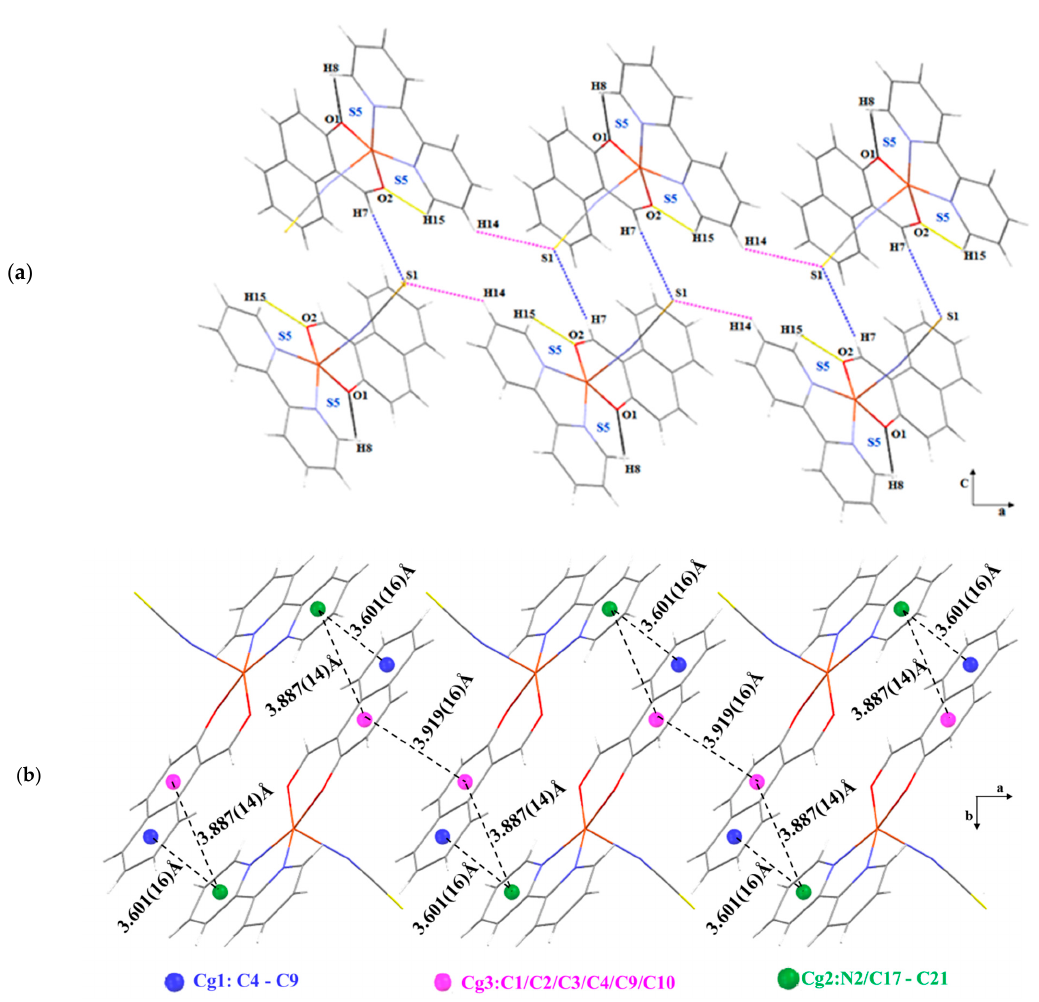
Figure 3. ( a ) Zig-zag chains of C-1 formed by hydrogen bonds (dashed lines), ( b ) the aromatic ring organization with centroid–centroid distances (Å). In addition, the C-1 complex exhibits three π ··· π stacking interactions; the first is be- tween the centroid of the 2-hydroxy-1-naphthaldehyde ring Cg1 (C4 to C9) and the cen- troid of the 2,2 ′ -bipyridine ring Cg2 (N2 and C17 to C21), with a Cg1…Cg2 distance of 3.601 Å, the second is between the Cg3 (C1/C2/C3/C4/C9/C10) rings of the 2-hydroxy-1- naphthaldehyde, with a Cg3···Cg3 distance of 3.919 Å, and the third is between Cg2 and Cg3, with a distance of 3.887 Å (Figure 3b).